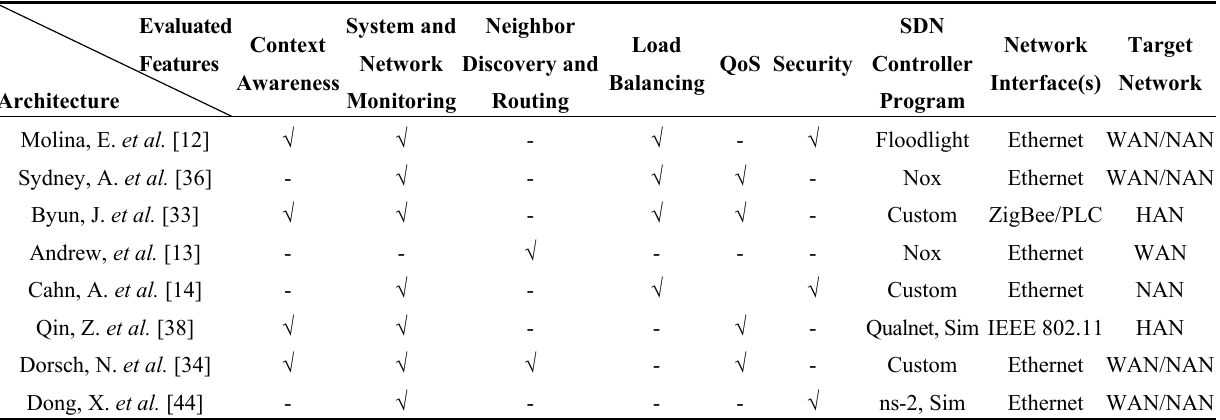
Table 1. Comparison between candidate SDN smart grid